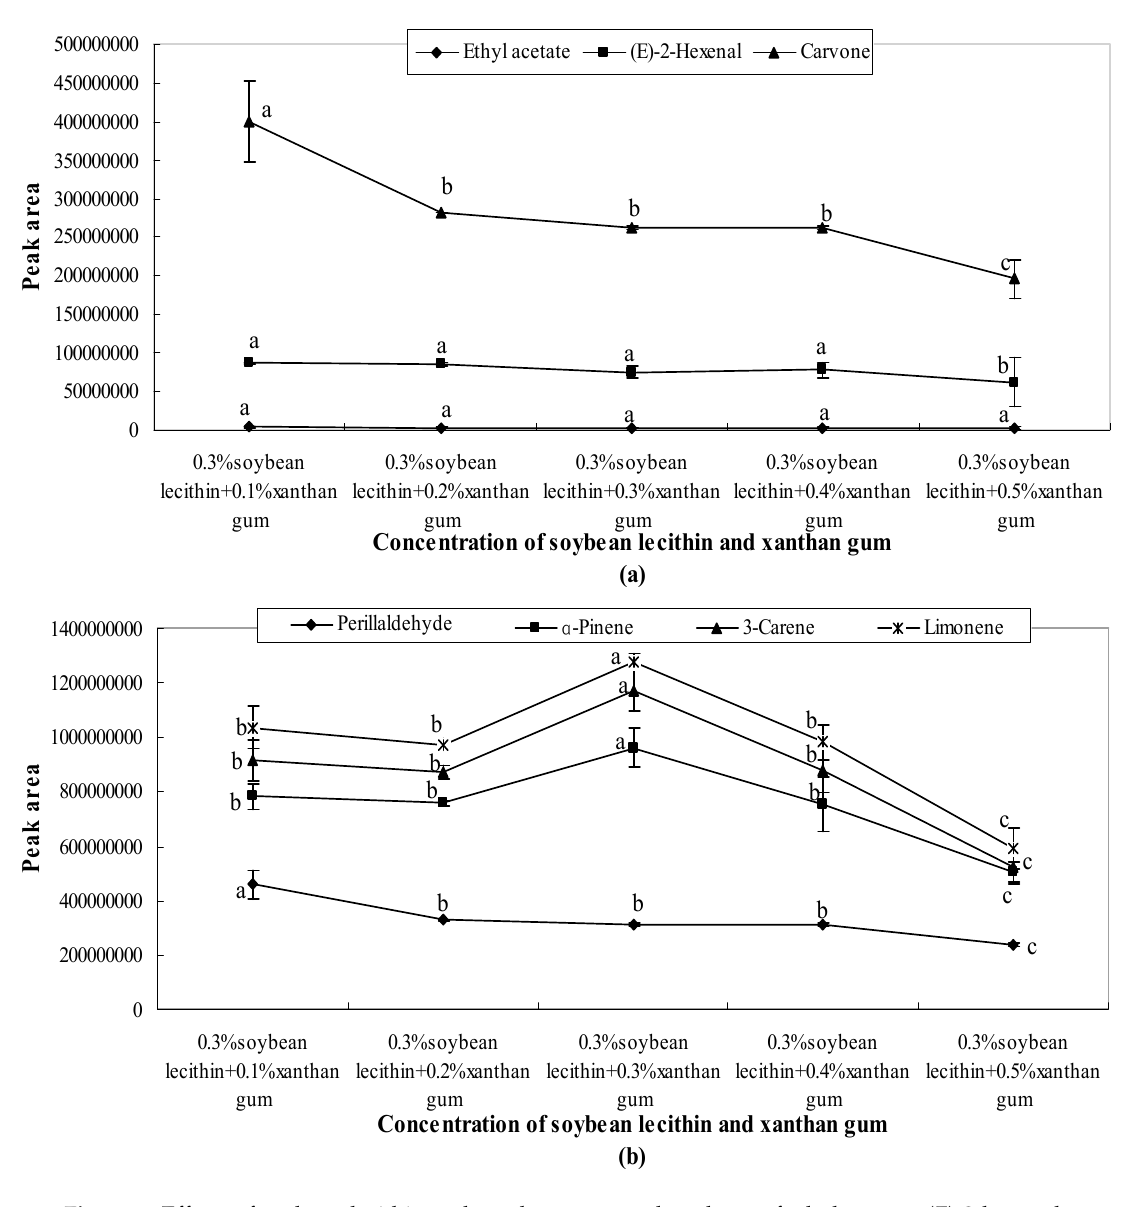
Figure 6. Effects of soybean lecithin and xanthan gum on the release of ethyl acetate, ( E )-2-hexenal, carvone ( a ) and perillaldehyde, α -pinene, 3-carene, limonene ( b ). Significant differences ( p < 0.05) between different concentrations are performed by letters on the same polylines. Where the letters on the same polyline are the same, there is no significant difference between different concentrations. (3) When 0.3% sucrose fatty acid ester was mixed with xanthan gum at different concentrations (0.1%, 0.2%, 0.3%, 0.4%, and 0.5%), aroma release showed a sharp decline after 0.4% (Figure 7). The lowest peak areas were observed when the concentration of xanthan gum was